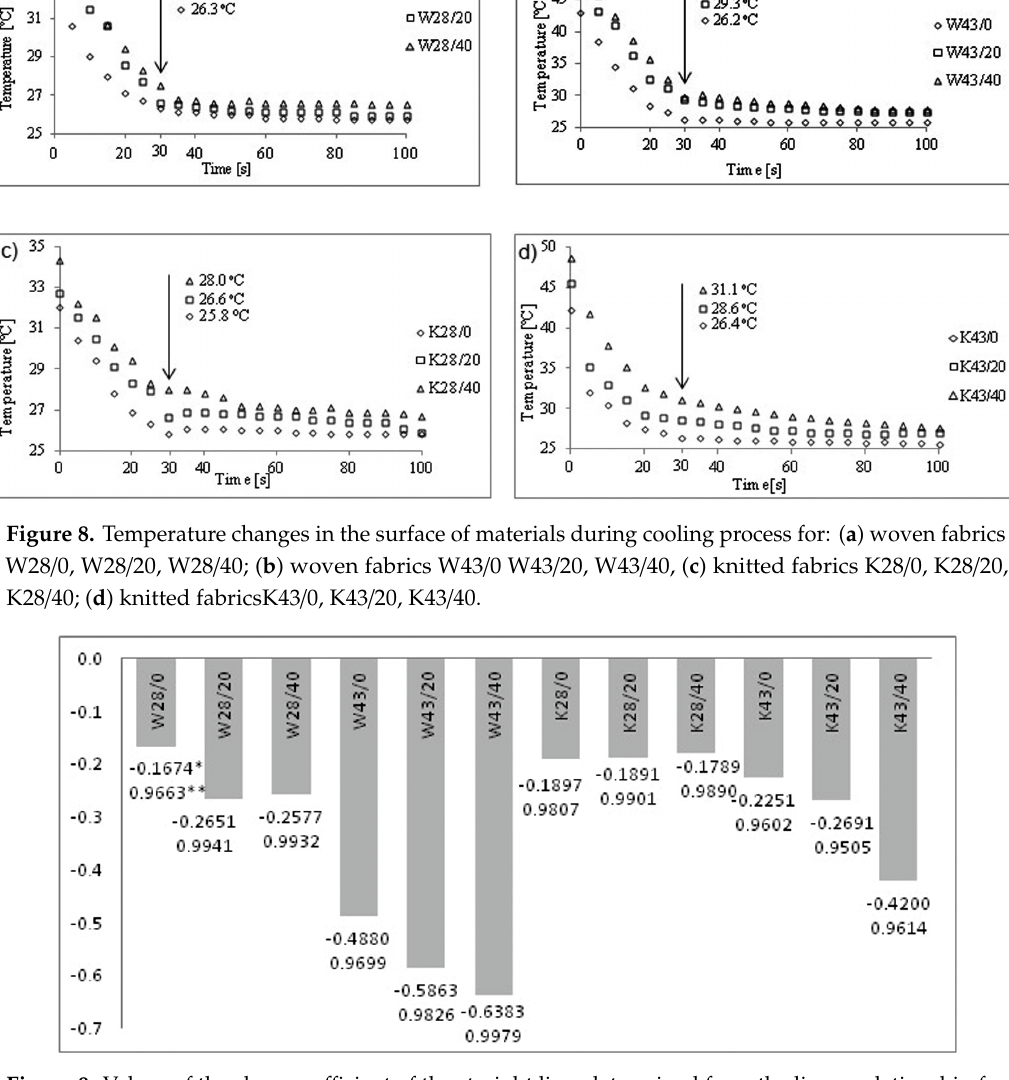
Figure 8. Temperature changes in the surface of materials during cooling process for: a ) woven fabrics W28/0, W28/20, W28/40; b ) woven fabrics W43/0 W43/20, W43/40, c ) knitted fabrics K28/0, K28/20, K28/40; d ) knitted fabricsK43/0, K43/20, K43/40.